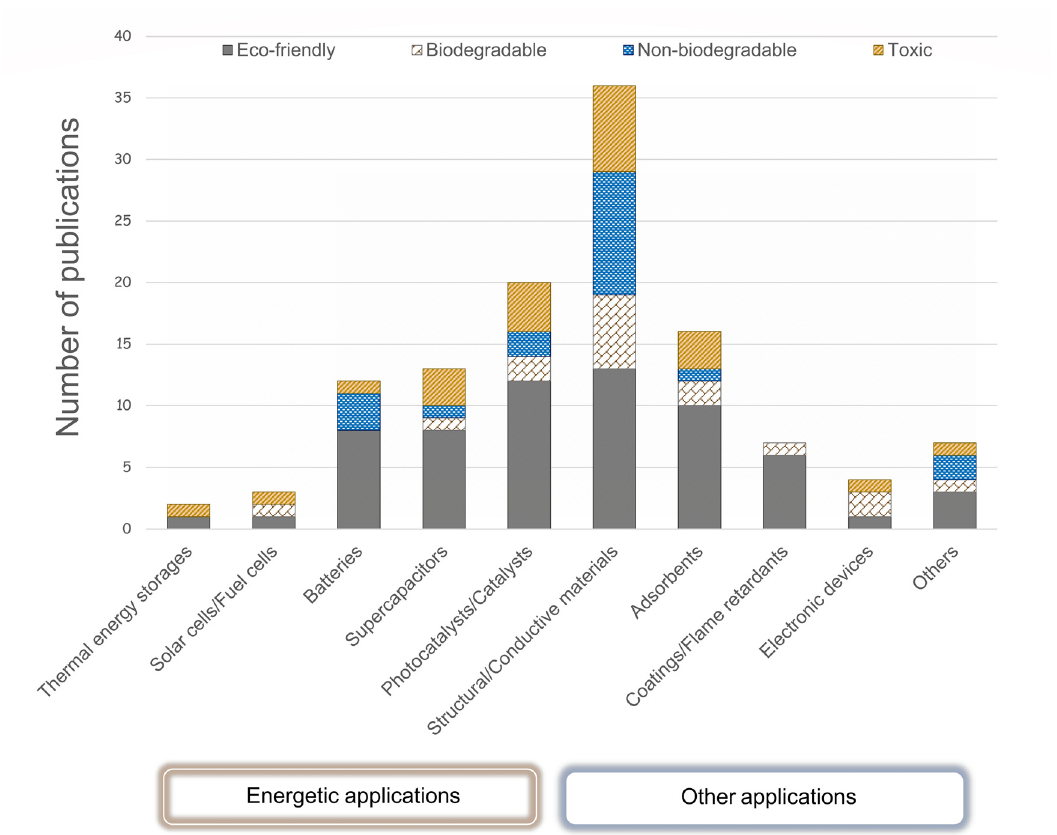
Figure 7: Waste - derived graphene composites in the current literature classi fi ed by their respective fi eld of